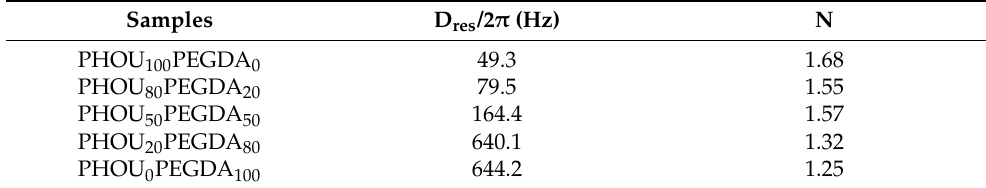
Table 3. D res and n values obtained by 1 H DQ NMR for the studied networks. Samples D res /2 π